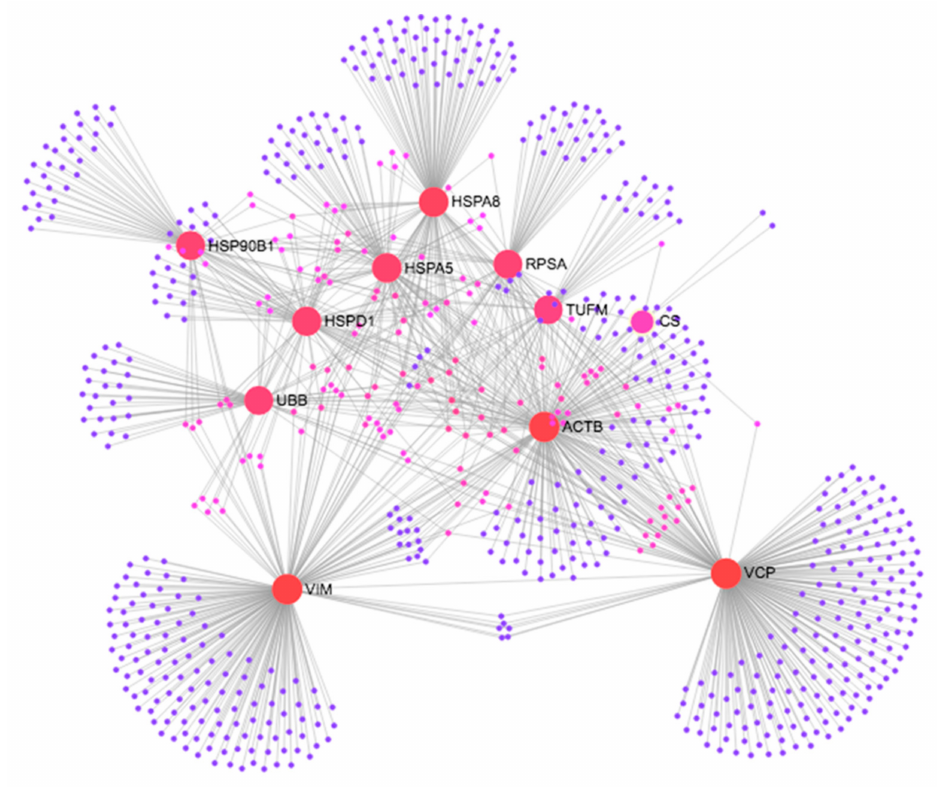
Figure 5. Protein–Protein Interaction of the proteins identified in the ovarian cancer cell